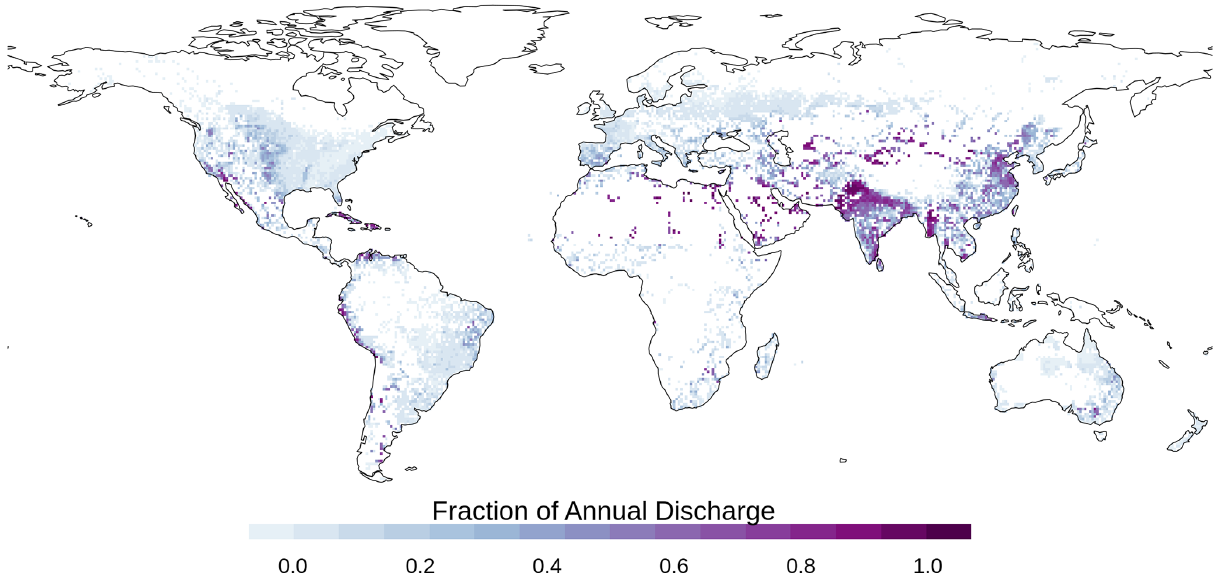
Figure 11. Fraction of average annual discharge composed of irrigation return flow water, simulated by the return flow tracking function. The large fraction of irrigation return flows in northern India and Pakistan results from this region being one of the most intensively irri- gated regions in the world, combined with very low ( ∼ 30%) classical irrigation efficiency (Zaveri et al., 2016; Grogan et al., 2017). This combination means that large volumes of water are extracted for irrigation, and nearly two-thirds of that water returns to the system.